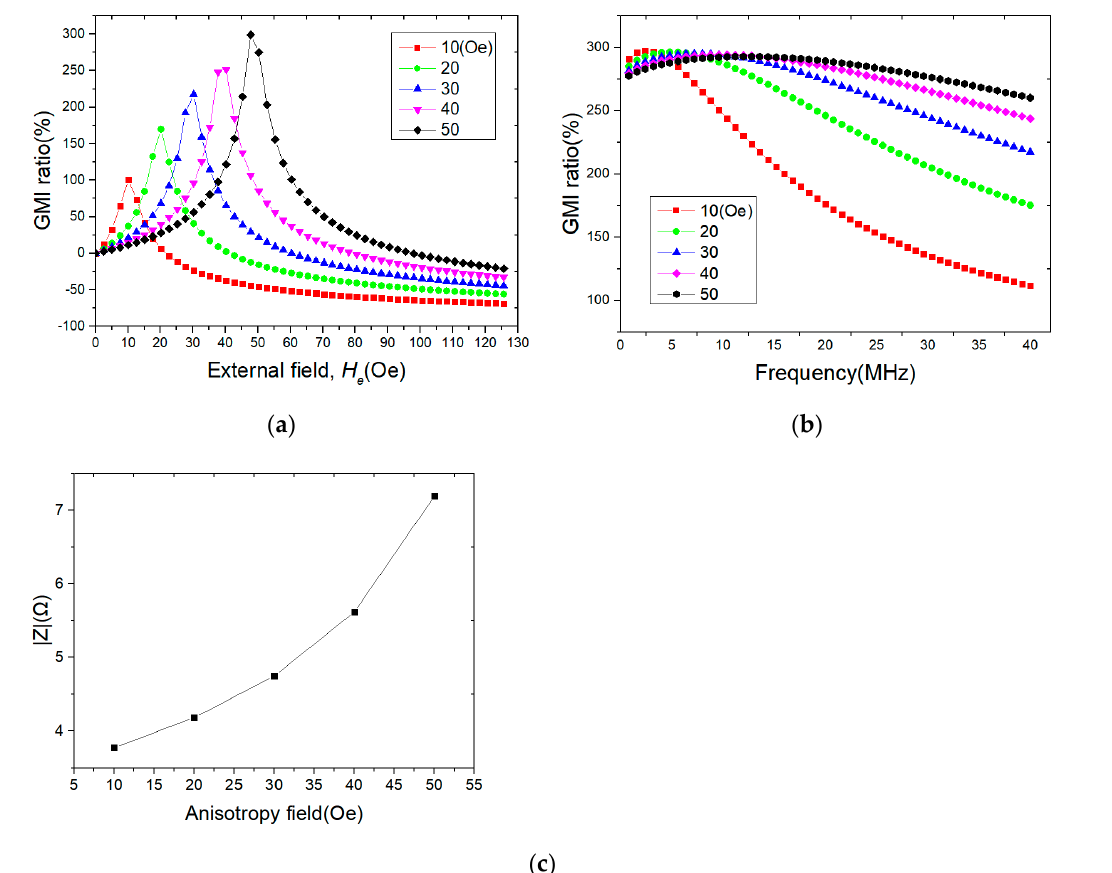
Figure 2. Effect of anisotropy field on GMI effect in cylindrical alloy fiber. ( a ) Curve of GMI effect with external field. ( b ) Curve of GMI effect with frequency. ( c ) Curve of impedance value with anisotropy field.